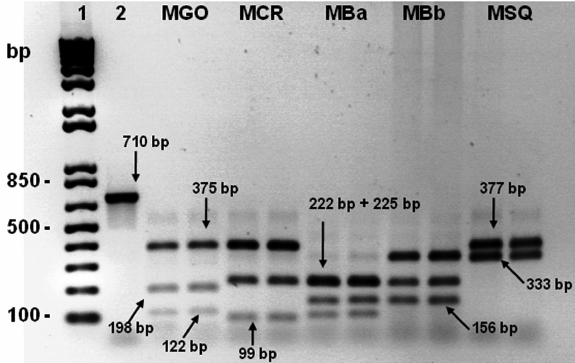
Fig . 3. – RFLP analysis of the COI mtDNA segments after diges- tion with Hpy CH4V and Ase I. Molecular weight standard (1); un- digested fragment (2); Maja goltziana (MGO); M. crispata (MCR); M. brachydactyla , pattern a (MBa); M. brachydactyla , pattern b (MBb); M. squinado (MSQ).